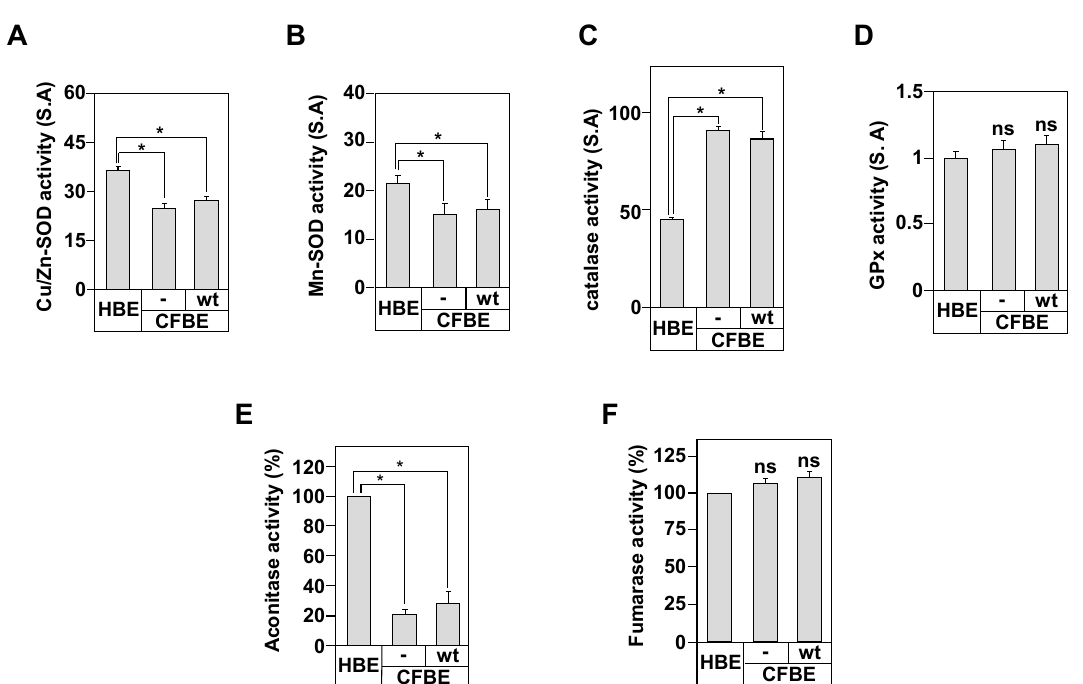
Figure 2. Characterization of the oxidant/antioxidant system in CF bronchial cells. Cu/Zn-SOD ( A ), Mn-SOD ( B ), catalase ( C ), glutathione superoxydase (GPx) ( D ), aconitase ( E ), and fumarase ( F ) activities were measured in HBE, CFBE, and CFBE-wt cells as described in Materials and Methods. One unit of the total SOD activity was defined as the amount of enzyme that inhibits the rate of pyrogallol autoxidation by 50%. The absorbance was measured at 420 nm for 5 min. Catalase activity was determined at 240 nm by measuring the decomposition of hydrogen peroxide (H 2 O 2 ). GPx activity in the samples was determined by monitoring the decrease in NADPH absorption at 340 nm for 3 min. Aconitase activity was measured by monitoring the formation of cis-aconitate upon addition of iso-citrate (20 mM), at 240 nm and 25 ◦ C. Fumarase activity was determined by measuring the increase in the absorbance at 240 nm at 25 ◦ C. Values with an asterisk are significantly different from their corresponding controls ( p < 0.05). Data are expressed as mean ± SE ( n =